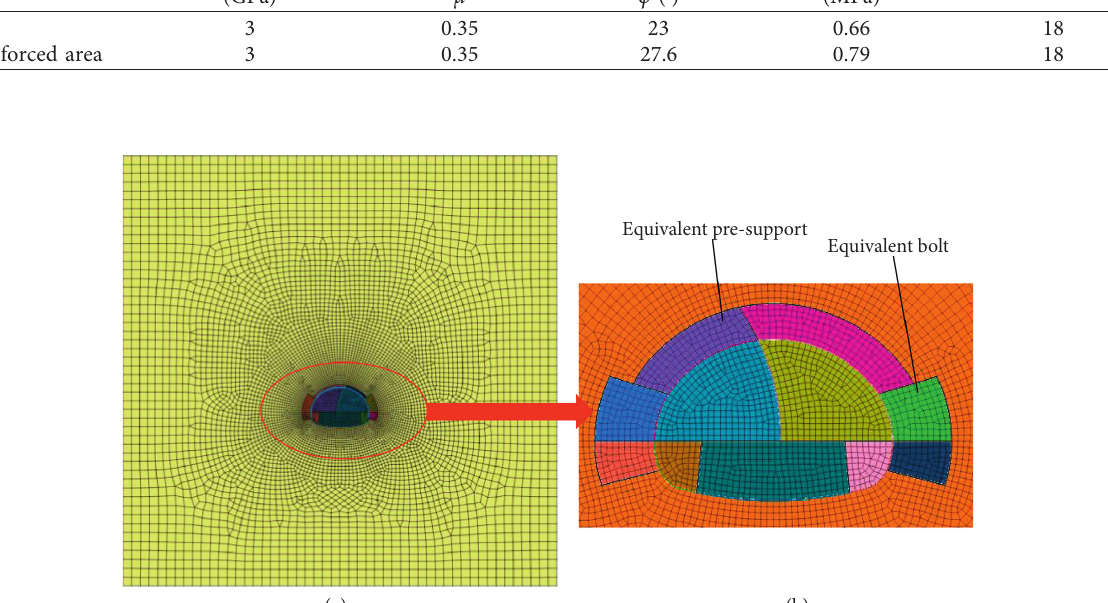
Figure 5: Primary supporting model of sections near tunnel portal. (a) Overall model. (b) Partial model.